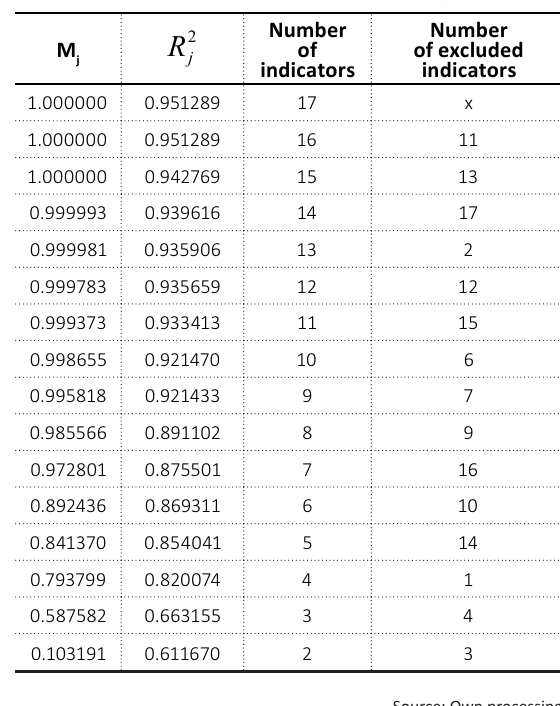
Table 5. Trends of cumulative characteristics when gradually eliminating indicators from 17 to 2